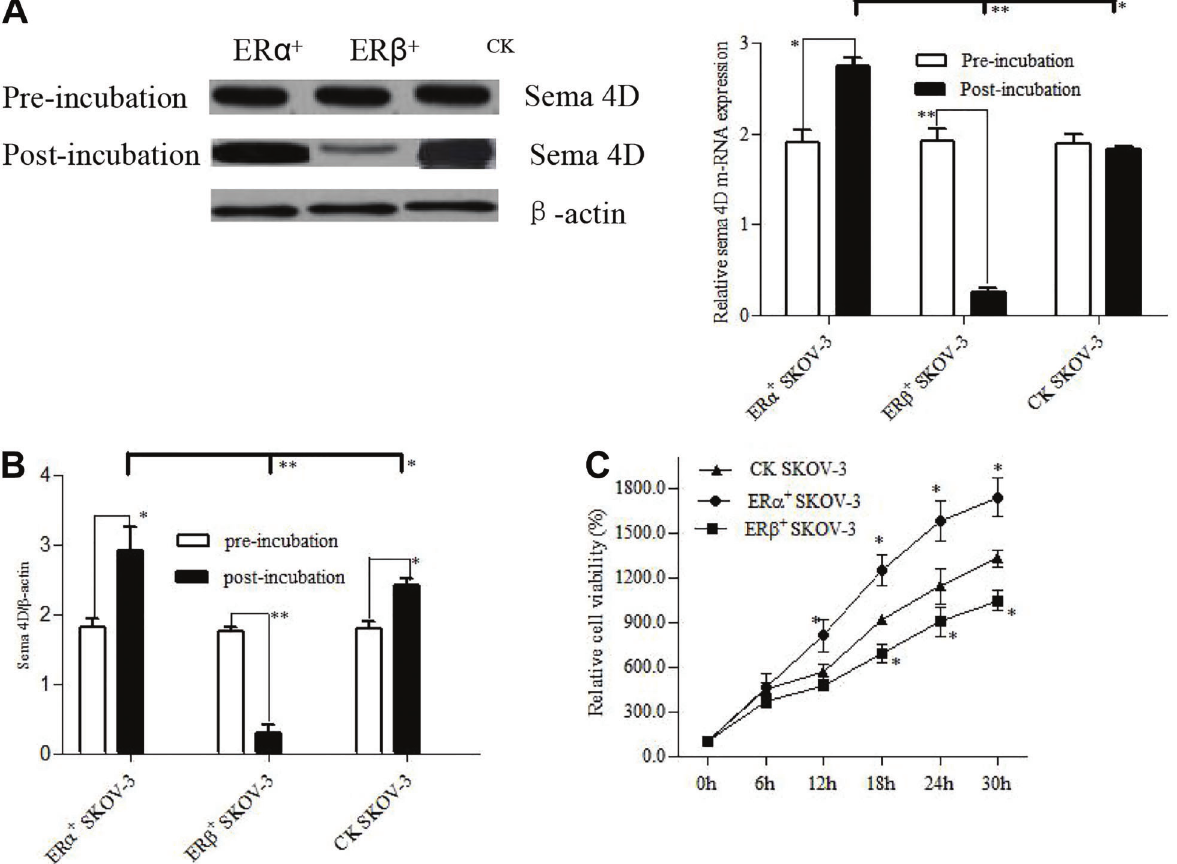
Figure 4. Effect of estrogen receptors (ERs) activator with 17 b -estradiol (E2) incubation on semaphorin (sema) 4D expression and cell proliferation. A , sema 4D m-RNA expression by RT PCR. B , sema 4D protein expression by western blotting. b -actin was used as the internal standard. C , Cell proliferation assay. Data are reported as relative viability of cells represented by the ratio of OD 450 values. Experiments were carried out in triplicate. Data are reported as means ± SD (*P o 0.05, **P o 0.01,